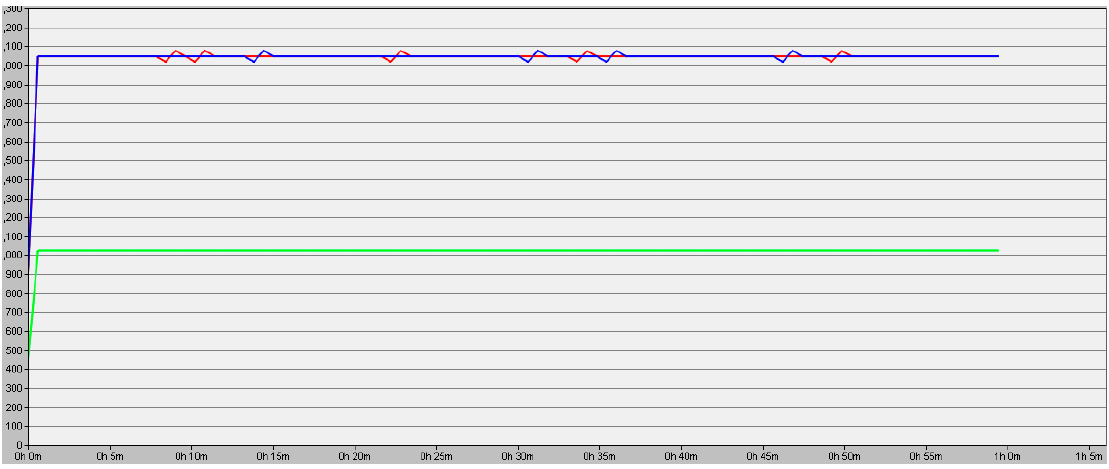
Figure 8. Improvement of Energy Efficiency (2). (X axis: Time, Y axis: Energy efficiency).